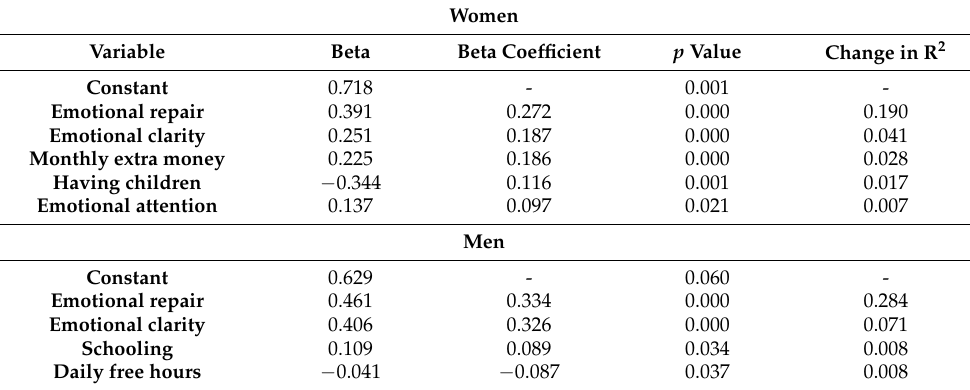
Table 5. Multivariate regression analysis for cognitive active coping in women and